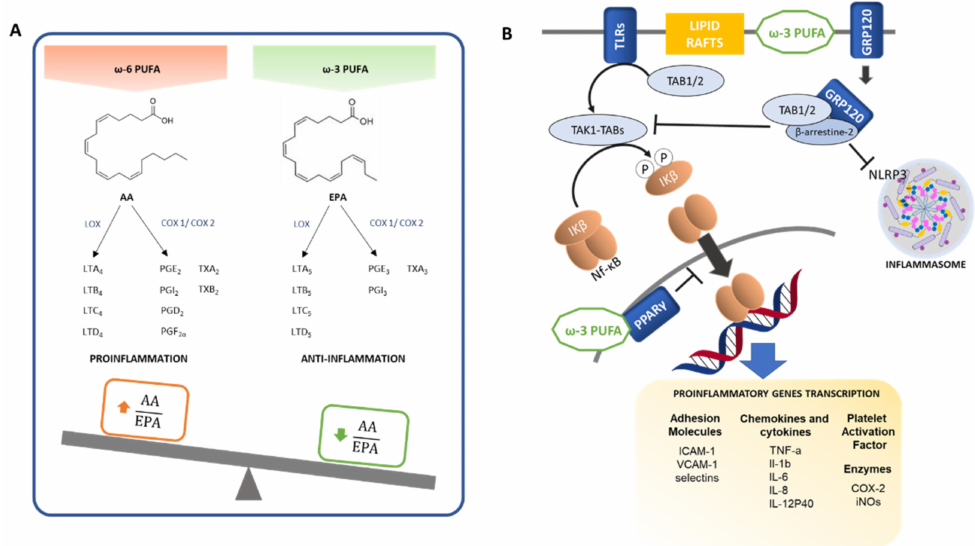
Figure 2. Anti-inflammatory actions of ω -3 PUFA. ( A ) ω -6 and ω -3 intake balance. ω -6 PUFAs are precursors of pro- inflammatory mediators while ω -3 PUFAs are precursors of anti-inflammatory mediators. ( B ) Mechanisms involved in the anti-inflammatory effects of ω -3 PUFAs. Thin arrows and bar-headed lines mean activation and inhibition of the pathway respectively. Thick arrows mean